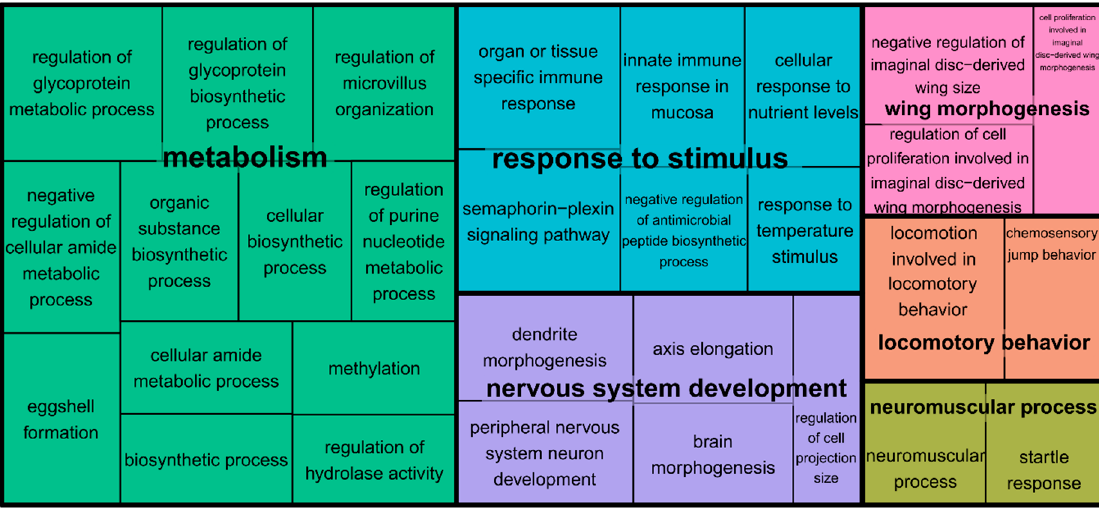
Figure 3. Treemap of enriched genetic oncology (GO) categories. The GO terms were subset, removing all of the redundant GO terms in REVIGO [98] at the medium-similarity criterion (0.7). The GO terms are grouped based on the taxonomic relations among them. The colors connect the GO terms belonging to the same cluster. The size of the panels scales with the negative 10-logarithm of the p -value for the enrichment test.